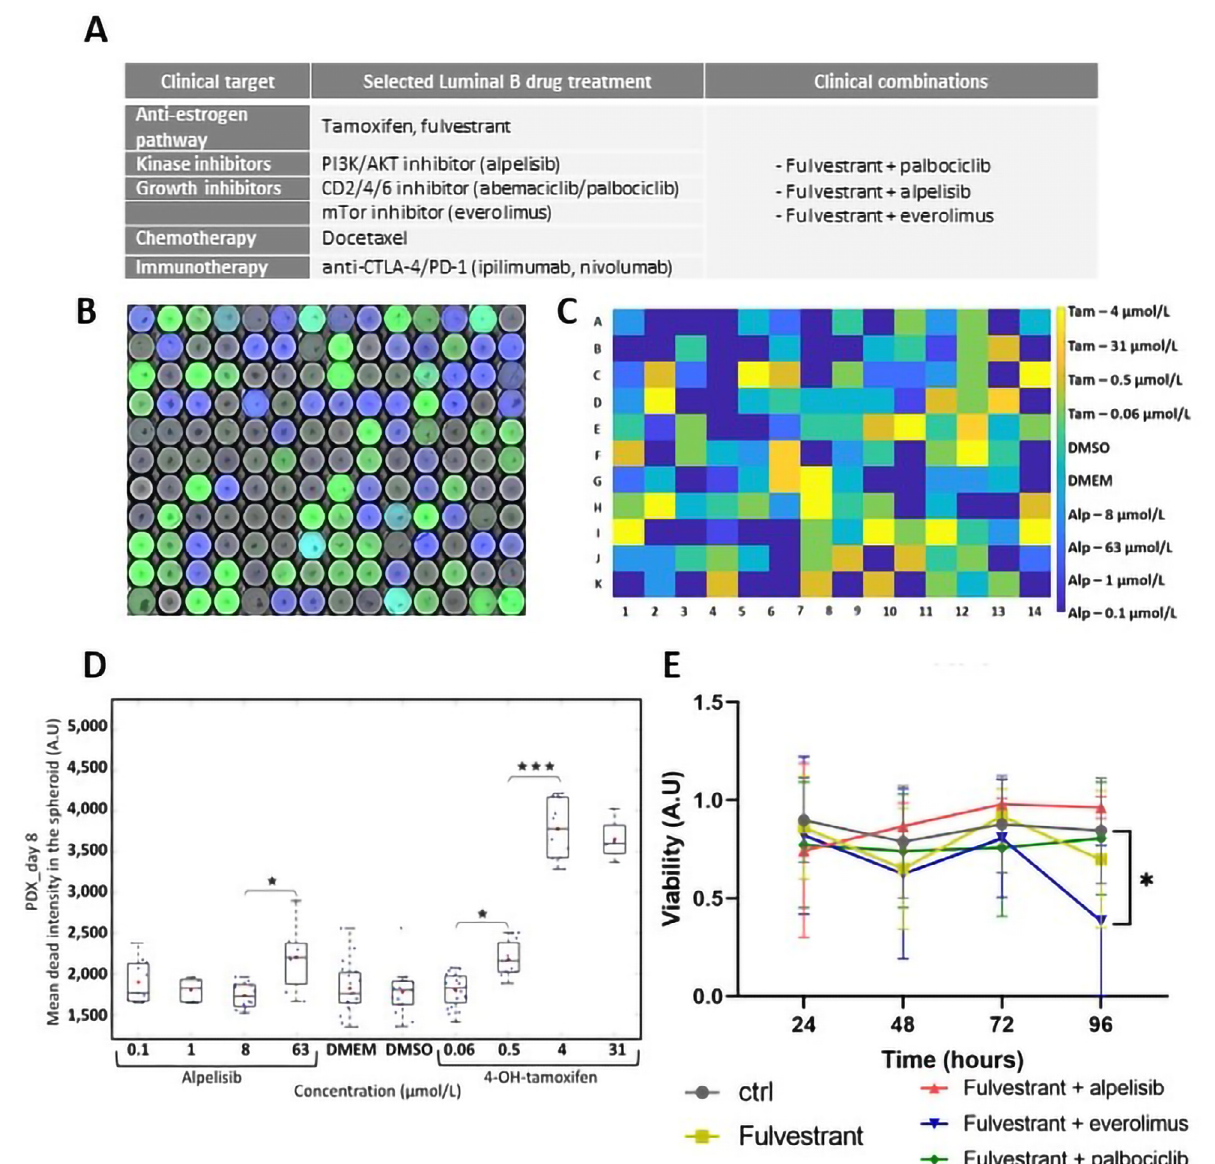
Figure 4. Treatment combination on LumB PDX. A) List of selected clinical treatments, including combinations used clinically; B) raw composite image combining 450 nm, 488 nm, and 647 nm analysis provides the key to identifying treatment-associated fluorescent labeling; C) in another experiment, barcode processing and image analysis provide the location for individual treatment for each well; D) cytotoxicity evaluated in PDX at day 8 for alpelisib and 4-OH-tamoxifen; E) viability over time after fulvestrant and combined treatments. Blue: control DMSO, orange: fulvestrant, yellow: fulvestrant + alpelisib, violet: fulvestrant + everolimus, green: fulvestrant + palbociclib. Statistical analysis: two-way ANOVA. P < 0.01. CTLA-4: cytotoxic *